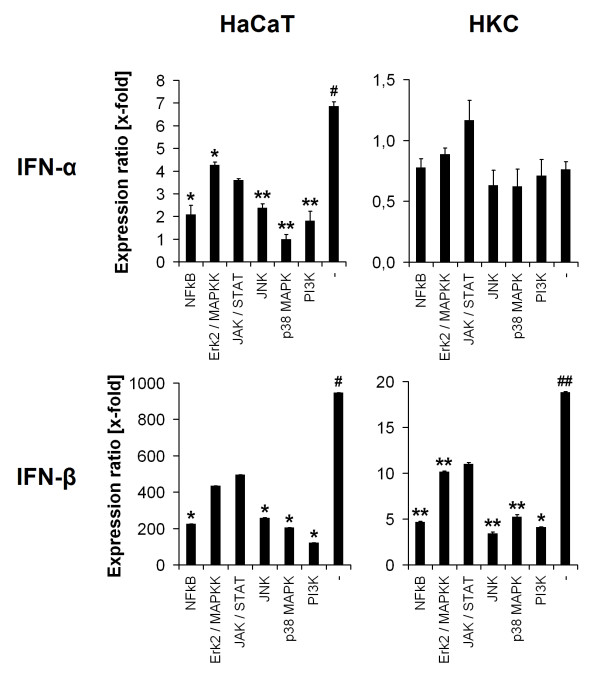
DNA recognition and signal transduction. RT-PCR analysis of type-I-interferon expression in HaCaT cells and HKC after preincubation with 10 μM of NFκB-, Erk2/MAPKK-, JAK/STAT-, JNK-, p38 MAPK- and PI3K-inhibitors (Sigma, Steinheim, Germany) for 1 h and stimulation with 5 μg S. cerevisiae DNA/ml medium for 6 h (HKC) and 15 h (HaCaT cells). The results were normalised to 18S ribosomal RNA (ratio: target gene/housekeeping gene) and compared to non-treated samples (vehicle control) (* = p < 0.05; ** = p < 0.005 to positive control (SC-DNA transfected, non-inhibited); # = p < 0.05; ## = p < 0.005 to vehicle control).